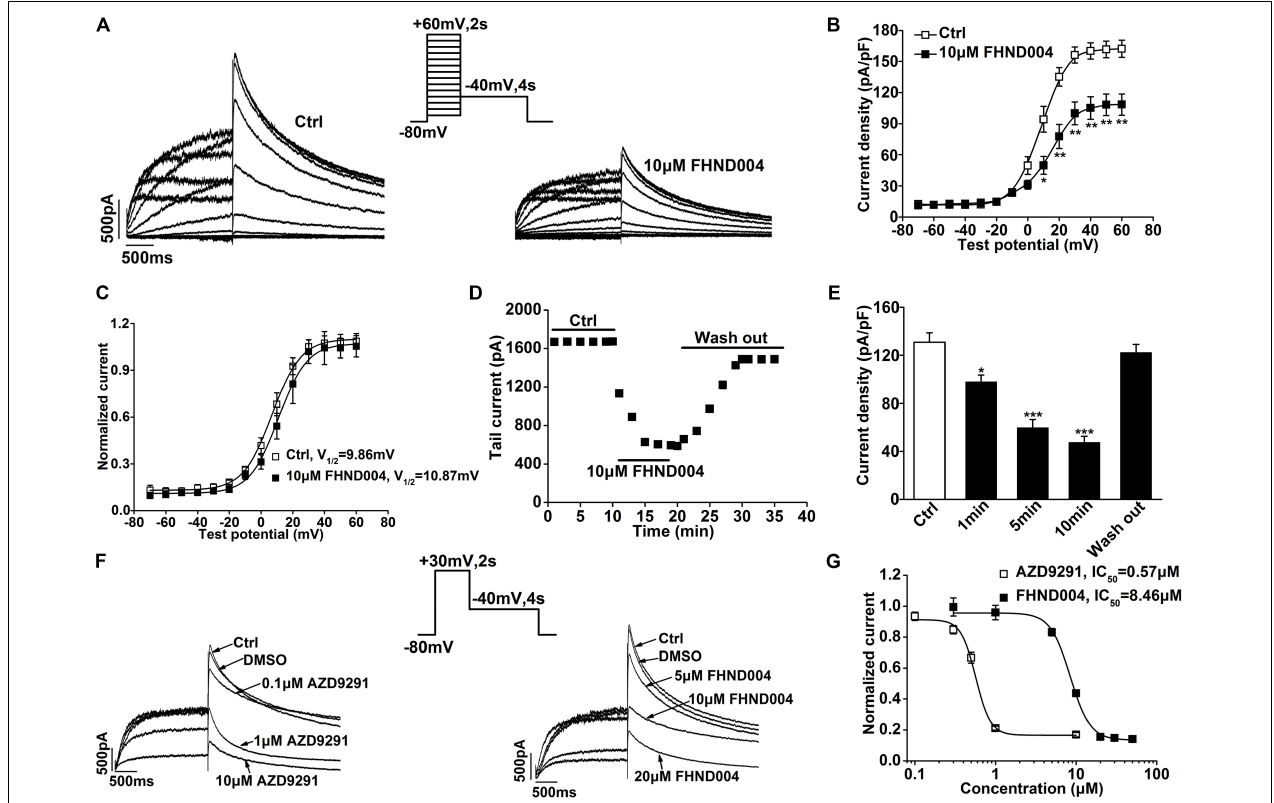
FIGURE 1 | Effects of FHND004 on I hERG recorded from HEK293 cells. (A) Families of I hERG elicited by 2 s pulses to the potentials between –70 and +60 mV in 10 mV increments from a holding potential of –80 mV and then back to –40 mV for 4 s in the absence and presence of 10 µ M FHND004. (B) I – V relationships for tail current in the absence and presence of 10 µ M FHND004 ( n = 8). (C) Steady-state activation curve fitted by a Boltzmann equation in the absence and presence of 10 µ M FHND004, respectively. (D) Time course of FHND004-induced inhibition of hERG tail current from the same cells ( n = 5). (E) The summarized peak current density in the absence and presence of 10 µ M FHND004. (F) Peak current elicited by a 30 mV depolarization pulse for 2 s and then back to –40 mV for 4 s under various concentrations of AZD9291 and FHND004, respectively. (G) Concentration–response relationships fitted with logistic equation for block of hERG tail current by AZD9291 and FHND004, respectively ( n ≥ 6 per data point). And the slope factor ( k ) for AZD9291 is 4.70 and k for FHND004 is 3.50. Panel (G) adapted from Zhang et al. (2017) with